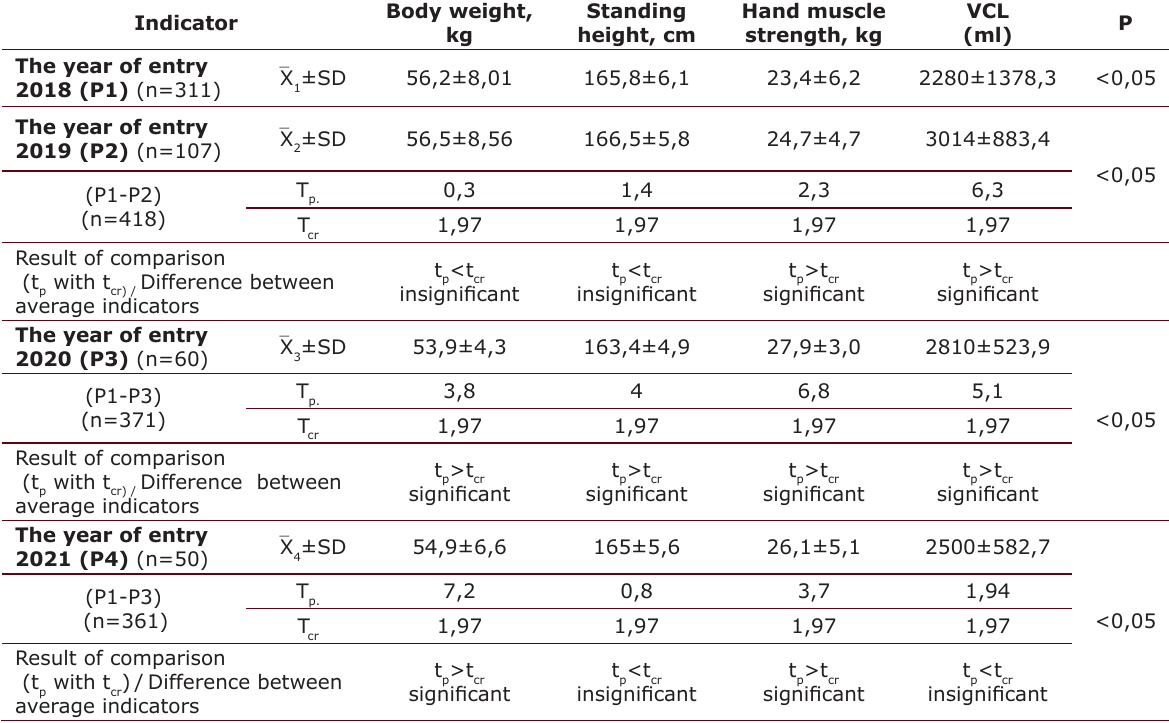
Table 1. Indicators of physical development in first-year female students in the 2018-2021 academic years Indicator